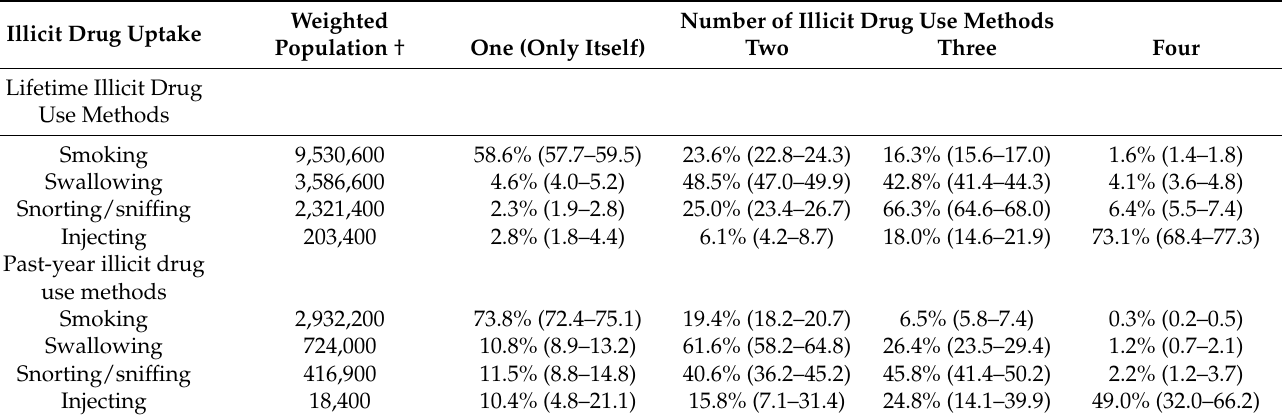
Table 3. Patterns of lifetime, and past-year illicit drug use